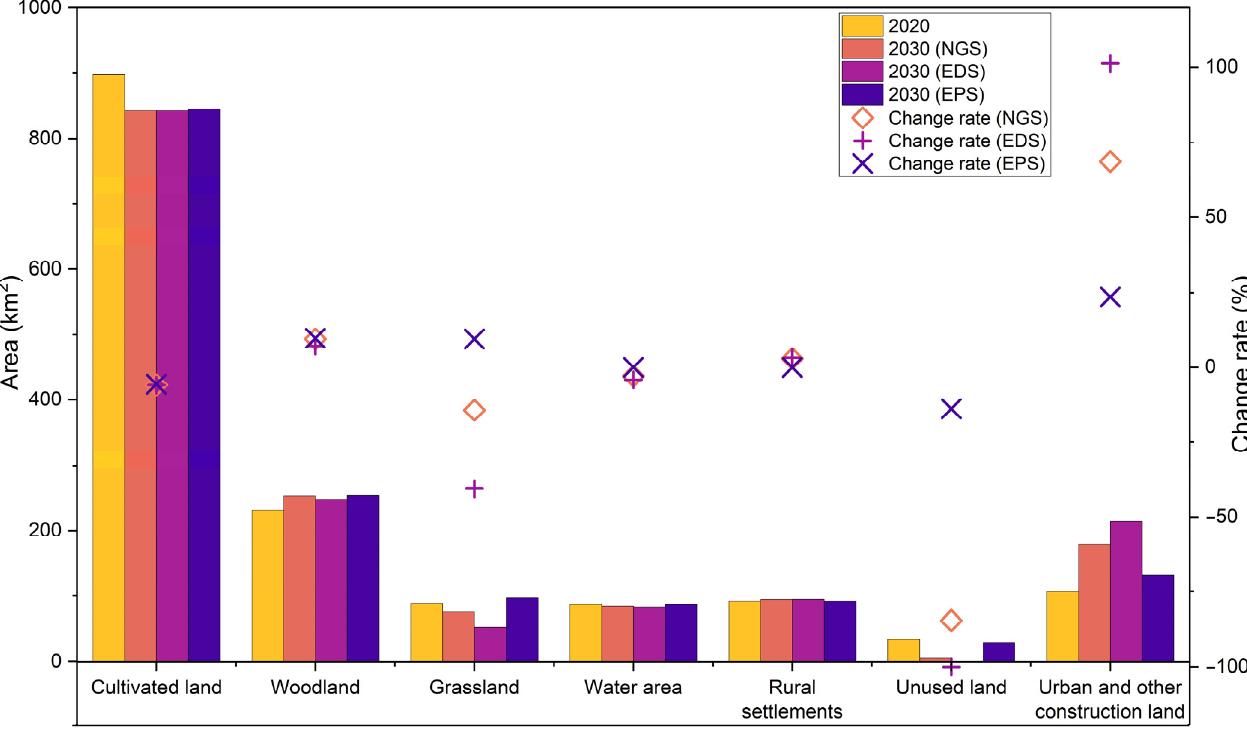
Figure 7. Land use conversion area chord diagrams. ( a ) NGS; ( b ) EDS; and ( c ) EPS. A1–A7 are the land use types in 2020; B1–B7 are the land use types in 2030; 1–7 represent cultivated land, wood- land, grassland, waters, rural se tt lements, unused land, and urban and other construction land. 3.3. Characteristics of Land Use Con fl icts The spatial distributions of the LUCs and the proportion of the area occupied by each con fl ict level are shown in Figure 8 and Table 2. The average con fl ict index increased in 2030 compared to 2020 in all scenarios, with the highest increase observed under the EDS. In 2020, high-level con fl ict areas accounted for 34.3%, were mainly sca tt ered along rivers and tra ffi c arteries, and were locally mixed with higher-level con fl ict areas, which ac- counted for 2.16%. The LUCs in 2030 under the EPS remained basically unchanged, while there were signi fi cant changes under the NGS and EDS. The area of high-level LUCs un- der the NGS increased slightly by 0.39%. The area of higher-level LUCs increased by about 1%, forming a ring-shaped pa tt ern around the city center. Under the EDS, the area of high-